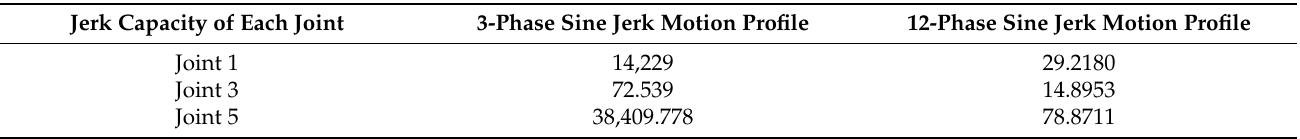
Table 5. Comparison of the peak jerk of each joints’ 3-phase and 12-phase.